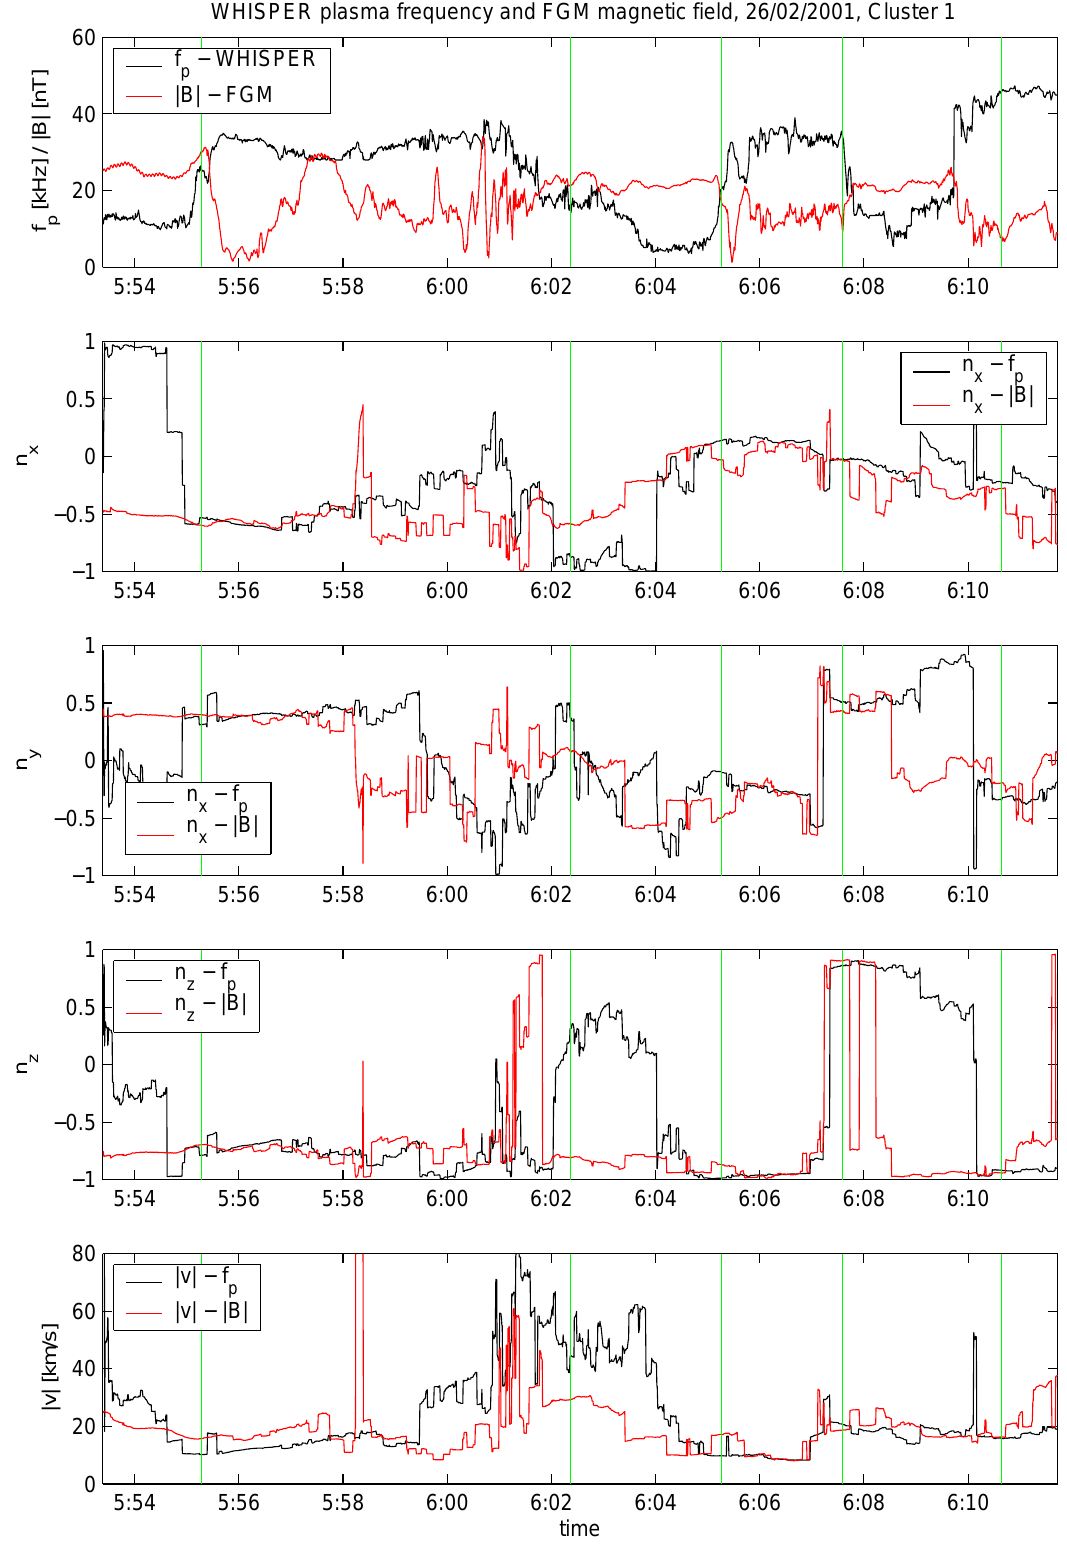
Fig. 6. Application of the LWC to multiple magnetopause crossings on 26 February 2001, from 05:53:30–06:11:30 UT. The upper panel shows the input data from spacecraft C1: total magnetic field from FGM (resampled at 4Hz), and plasma frequency from WHISPER (sampled at 2Hz). Panels 2 to 4 display the three components of the normal vector n of the discontinuities as determined from the magnetic field and the electron density data. The bottom panel shows the magnitude of the